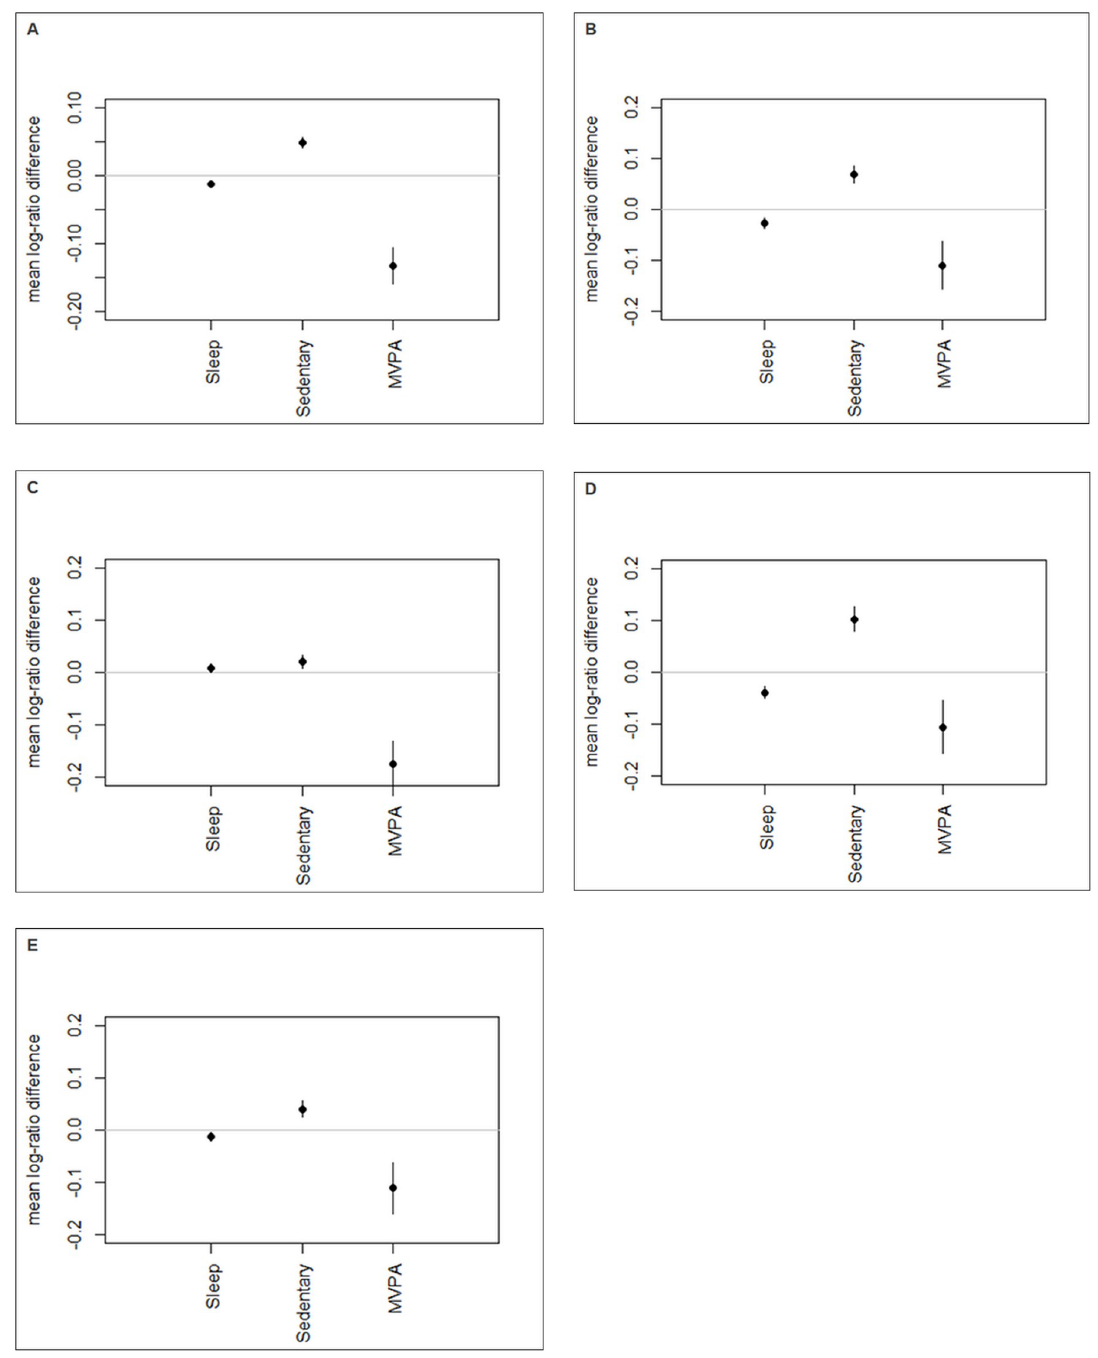
Fig 2. Change in movement behaviours over time. Note: Graphs display the mean log-ratio difference plots and their 95% confidence intervals for change over time of movement behaviours in the total sample (Panel A, n = 14,620), younger boys (Panel B, n = 2,836), older boys (Panel C, n = 2,264), younger girls (Panel D, n = 5,060), and older girls (Panel E, n = 4,460). MVPA, moderate-to-vigorous physical activity. These changes reflect changes in the relative contribution to the movement behaviours to the overall movement behaviour